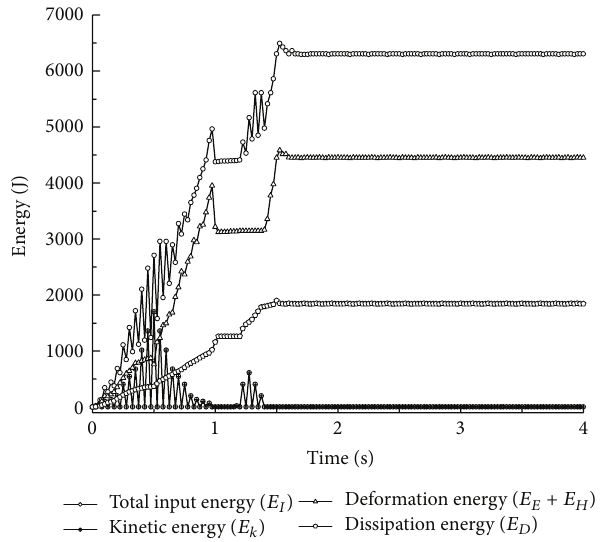
Figure 3: Time histories of energy responses in elastoplastic structure.